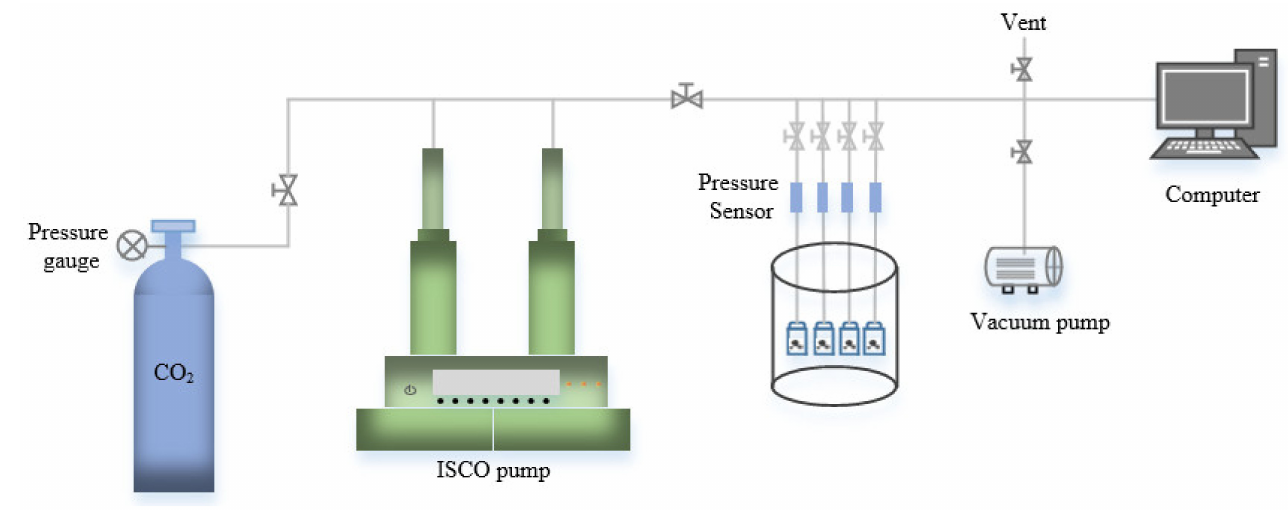
Figure 1. Experimental device for shale immersion.